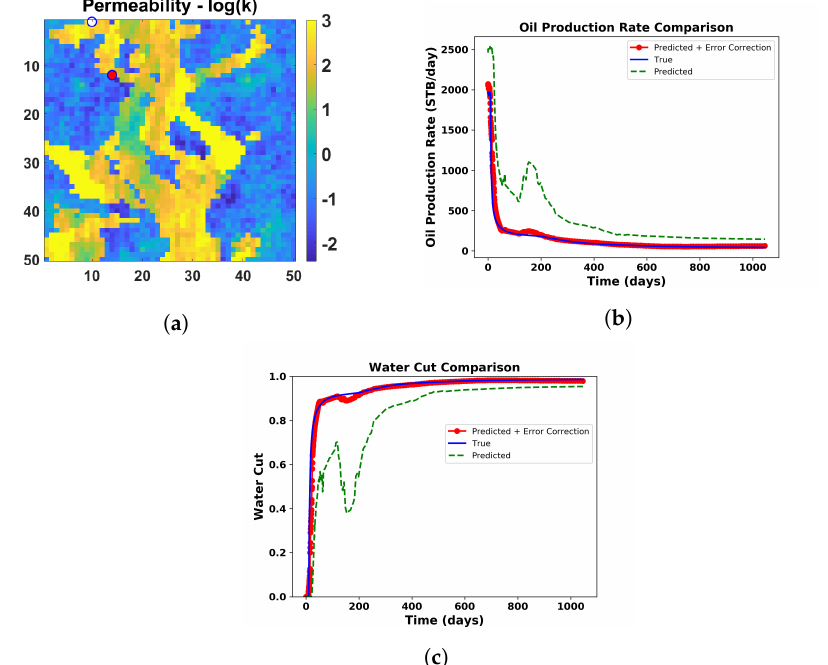
Figure 42. ( a ) Test case 3 with producer well location at (14,12). ( b ) Comparison of oil production rate and ( c ) comparison of water cut, predicted using the global PMOR method alone (dotted green line) and after the implementation of error correction model (red circled line) with the true solution (blue line).